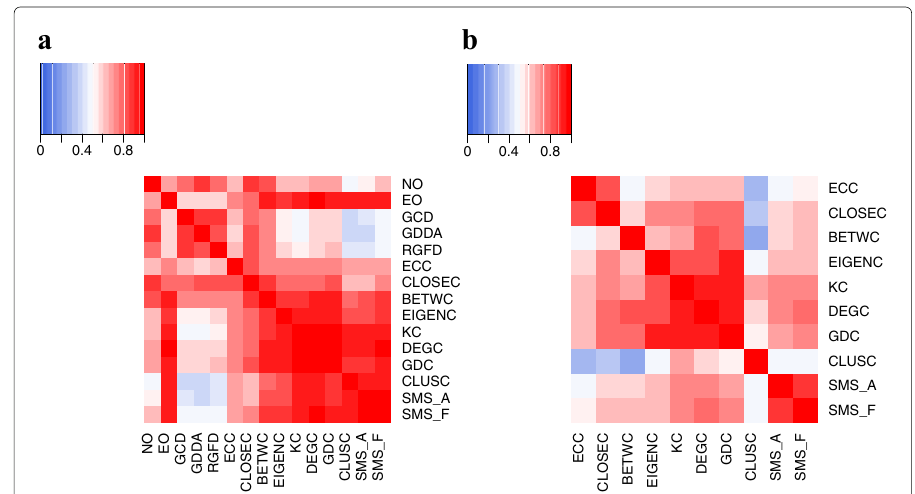
Fig. 6 Correlations between different global and local measures. a Spearman correlations between all pairs of the considered network similarity measures obtained by comparing the measures’ snapshot similarity matrices. b Spearman correlations between all pairs of the considered centrality measures obtained by comparing the centrality values over all nodes in all network snapshots. In each panel, the higher the matrix value, the higher the similarity between the corresponding measures. Please note that the different panels do not necessarily use the same color